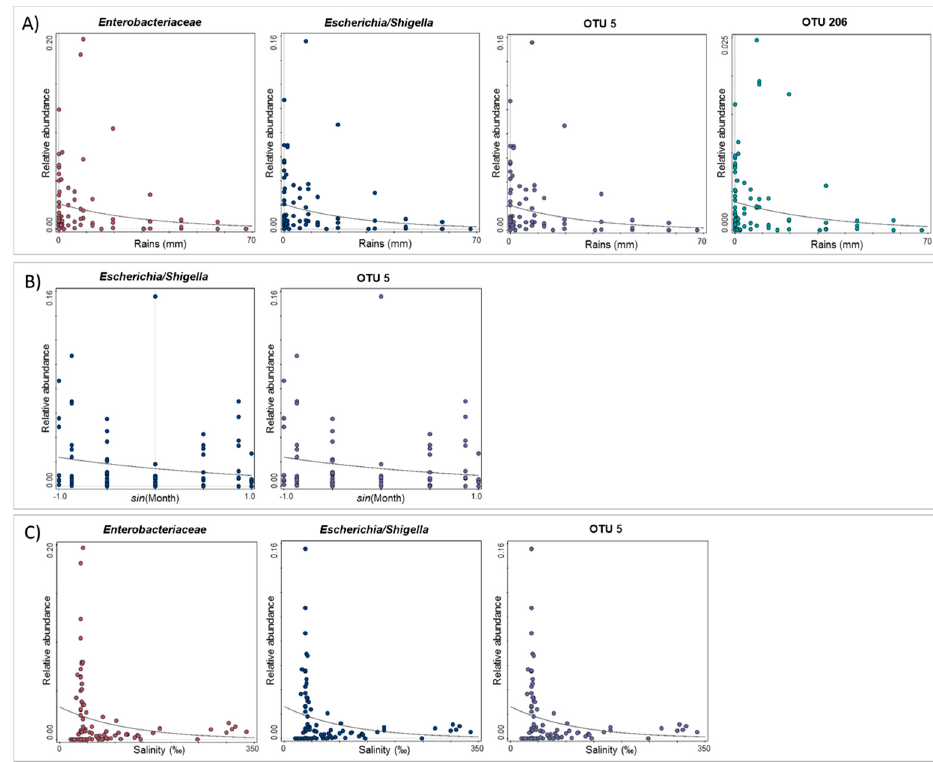
Figure 7. GLM plots showing the significant trends of the Enterobacteriaceae family, its key genus, and OTUs in relation to the environmental parameters. The abundance variation of Enterobacteriaceae, Escherichia/Shigella , OTU 5 and OTU 206 in relation to the rains ( A ); abundance variation of Escherichia/Shigella and OTU 5 in relation to the sin (Month) ( B ); and abundance variation of Enterobacteriaceae , Escherichia/Shigella and OTU 5 in relation to the salinity ( C ).